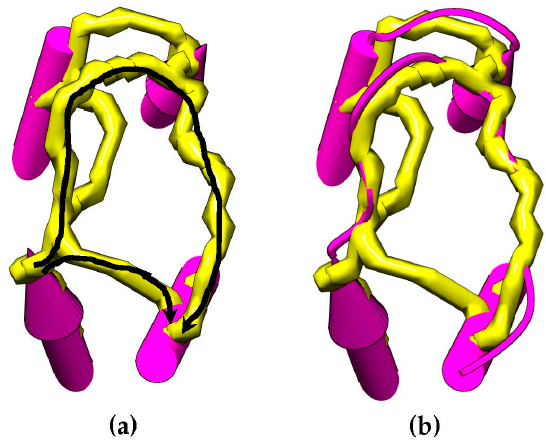
Figure 4. An example of paths for skeleton traces that can be found between two SSEs-V endpoints ( a ). Two paths are found (colored in black arrows). The native loop structure is shown ( b ) that shows that the longest path is the correct path. The length of the two paths is compared with the sLength of the loop and the path that best fits the loop is chosen to calculate the weight of the edge in G TOP